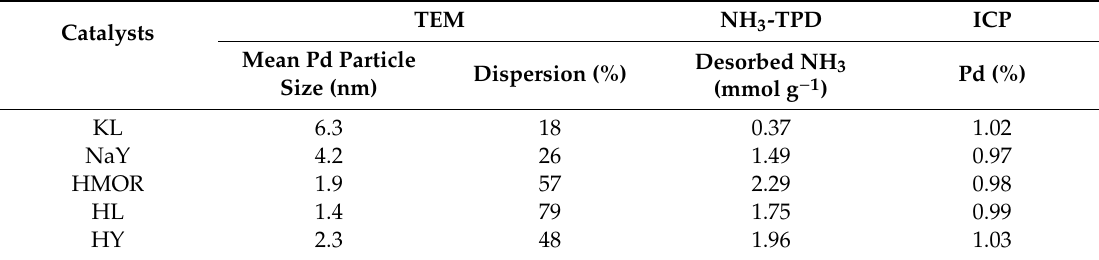
Table 2. Pd mean particle size and dispersion from TEM, total desorbed ammonia obtained from TPD-NH 3 and Pd metal mass content from